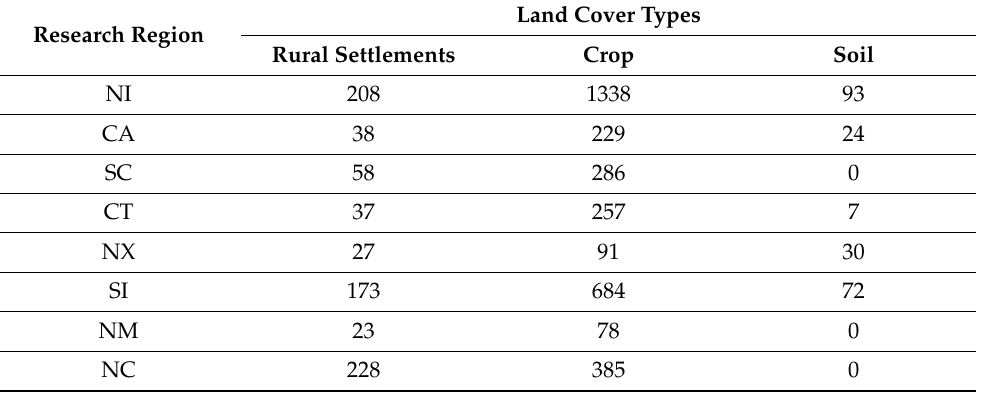
Table 1. The number of samples for each land cover class per region.